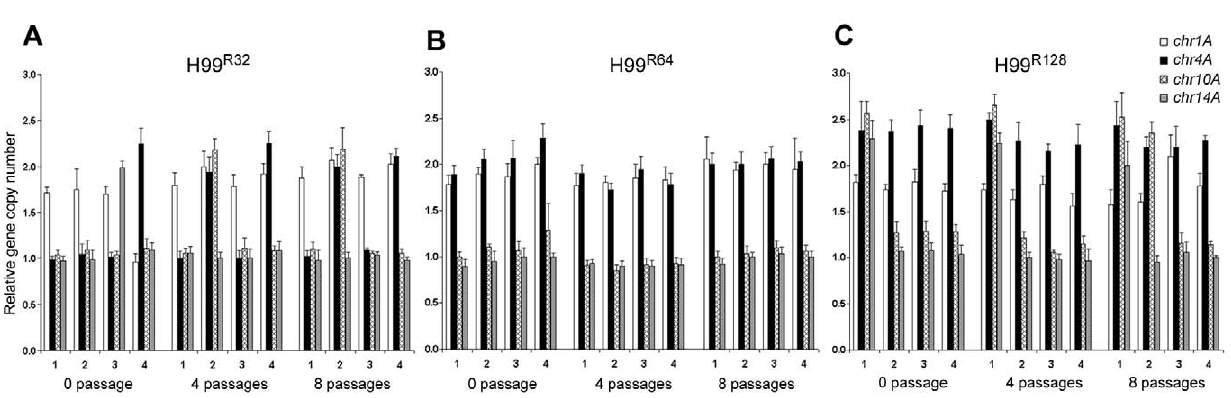
Figure 4. Gene duplication determined by colony qPCR. Gene dosage was determined by qPCR in four independent colonies of H99 derived strains by stepwise selection on YPD agar plates containing increasing concentrations of FLC: ( A ) 32 m g/ml; ( B ) 64 m g/ml; ( C ) 128 m g/ml. The relative gene copy number of four probes ( chr1A , chr4A , chr10A and chr14A ) located on Chr1, 4, 10, and 14 was compared to the control probe on Chr3 ( chr3A ). The 0 passage samples represent initial colonies that appeared 4 days after plating the parental strains on plates containing FLC. The gene duplication in those colonies was also determined following 4 and 8 passages on agar media with the same concentration of FLC.